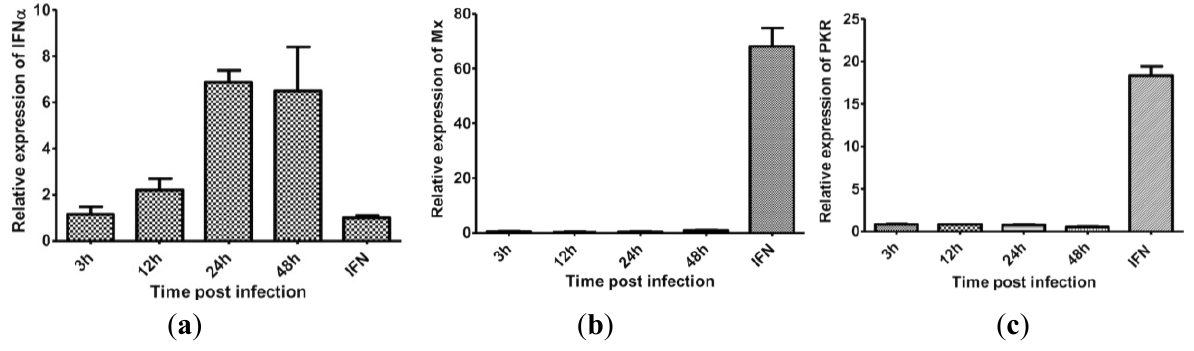
Figure 5. IFNα and Mx1 mRNA expression in IPNV-infected CHSE-214 cells. CHSE-214 cells were infected with IPNV, harvested at indicated time points, and IFNα ( a ), Mx1 ( b ) and PKR ( c ) mRNA expression were measured by real-time PCR. IFN is cells treated with recombinant IFNα for 4 days and used as positive control (n =